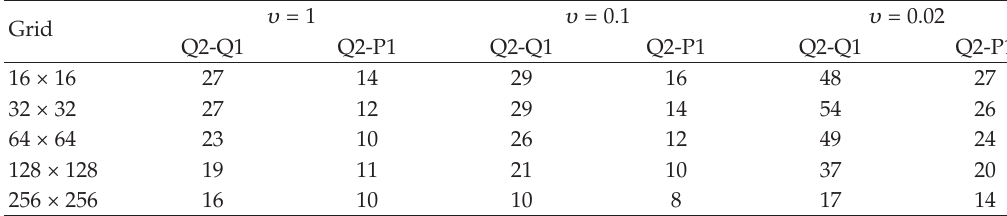
Table 2: Iterations of preconditioned GMRES (cid:4) 30 (cid:5) for steady Oseen problems (cid:4) Picard (cid:5) .